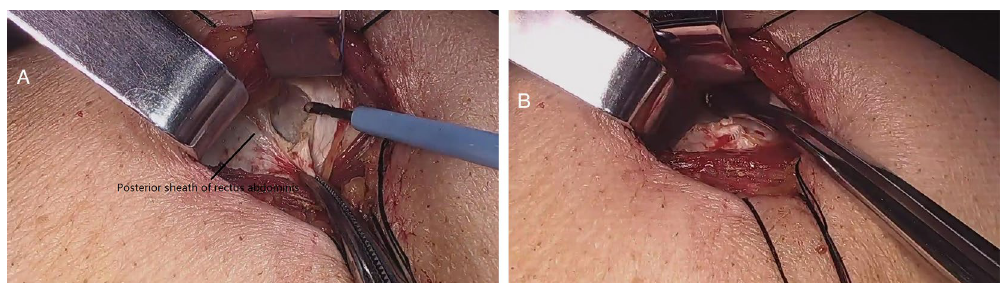
Figure 2. The transversus abdominis muscle was release from the lateral edge of the posterior rectal sheath ( A ) and the sheath was opened about 6 cm in width ( B ).